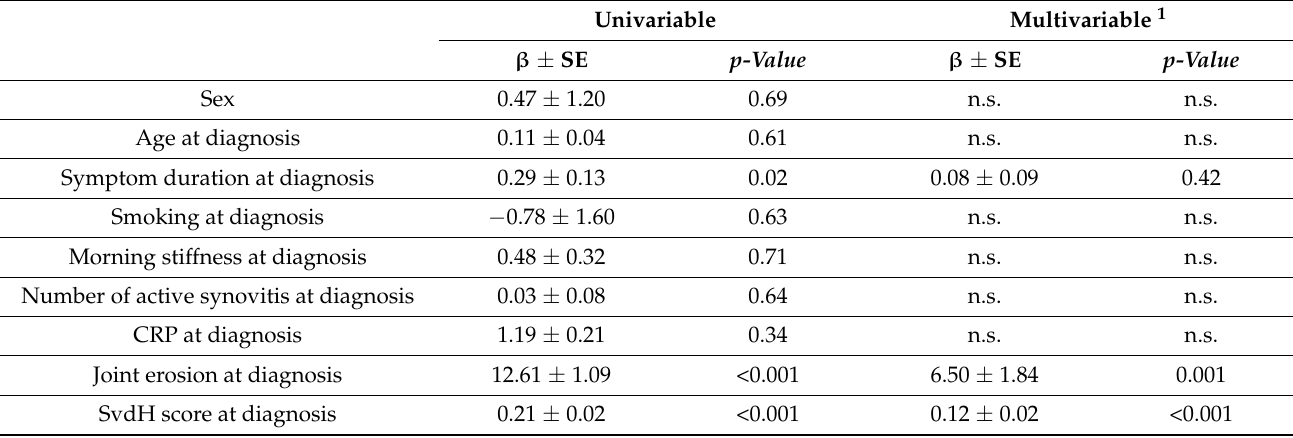
Table 3. Predictive factors of radiographic progression by using univariate and multivariate linear regression analyses in patients with seronegative rheumatoid